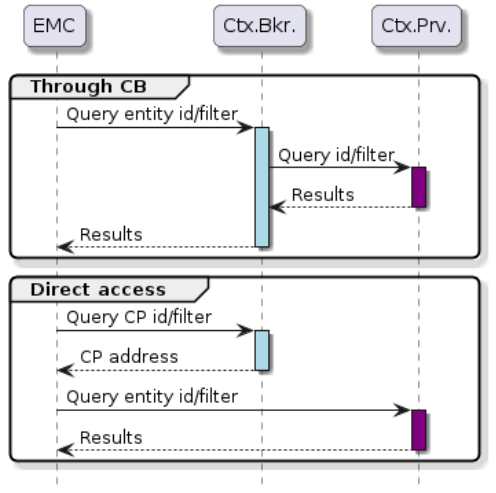
Figure 6. Context Provider information access sequence.